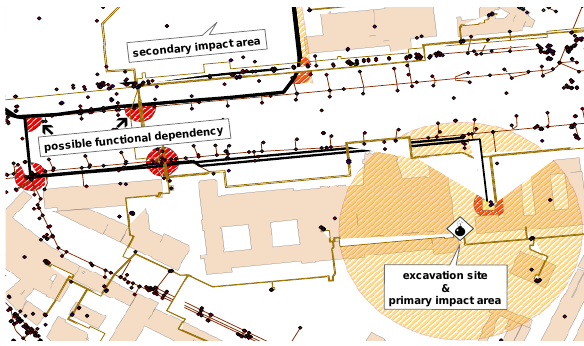
Figure 1. Scenario - excavation of a second world war bomb and its resulting impact